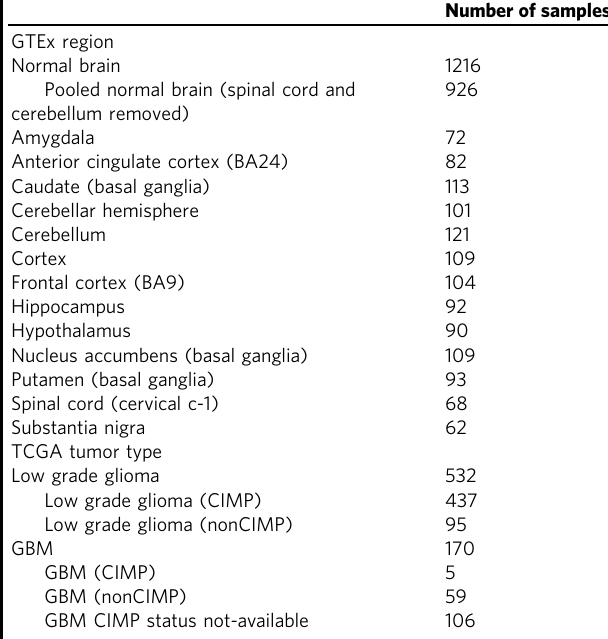
Table 1 GTEx normal brain regions and TCGA tumor